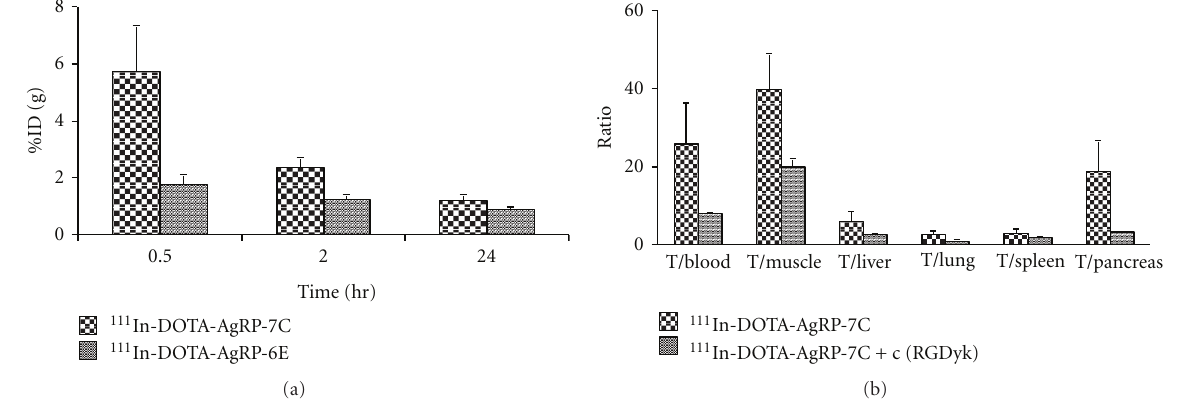
Figure 3: U87MG tumor uptake for 111 In-DOTA-AgRP-7C and 111 In-DOTA-AgRP-6E at 0.5, 2, and 24h p.i. (a). Tumor (T)-to-normal organ ratios for 111 In-DOTA-AgRP-7C with or without c(RGDyK) blocking peptide at 2h after the injection of the probe